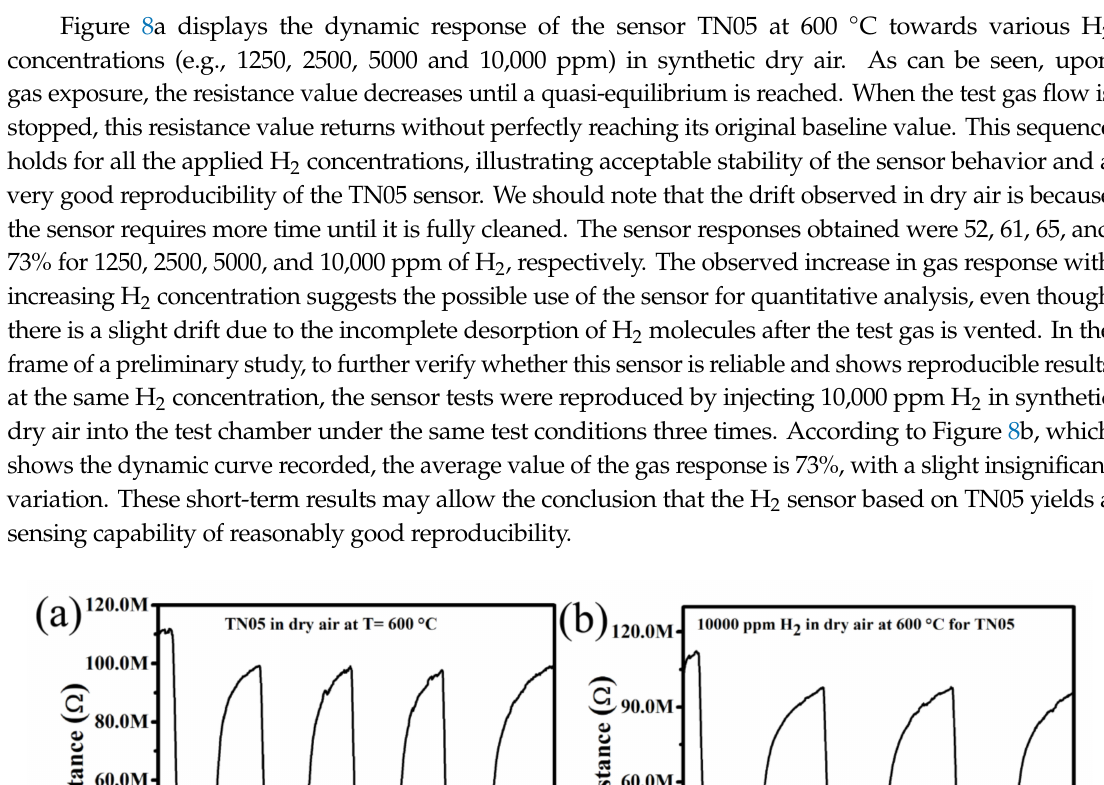
Figure 7. Response of gas sensor based on 0.5% Ni-doped TiO 2 to 10,000 ppm of H 2 in dry air at di ff erent operating temperatures.